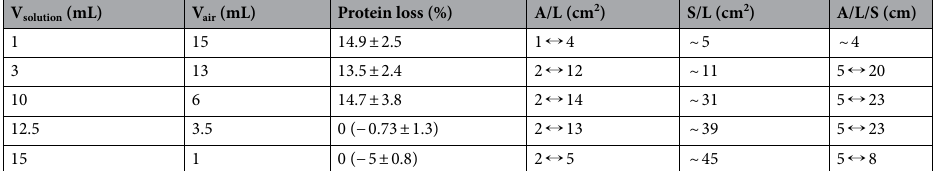
Table 1. Protein loss (%) for YPE cell extract in PP tubes as a function of the volume of solution and the evolution of the amount of A/L, S/L and A/S/L interfaces during the agitation (excluding waves and bubbles). The protein loss referred to a solution agitated at 3 rpm for 24 h at 6 °C (C 0 = 0.1